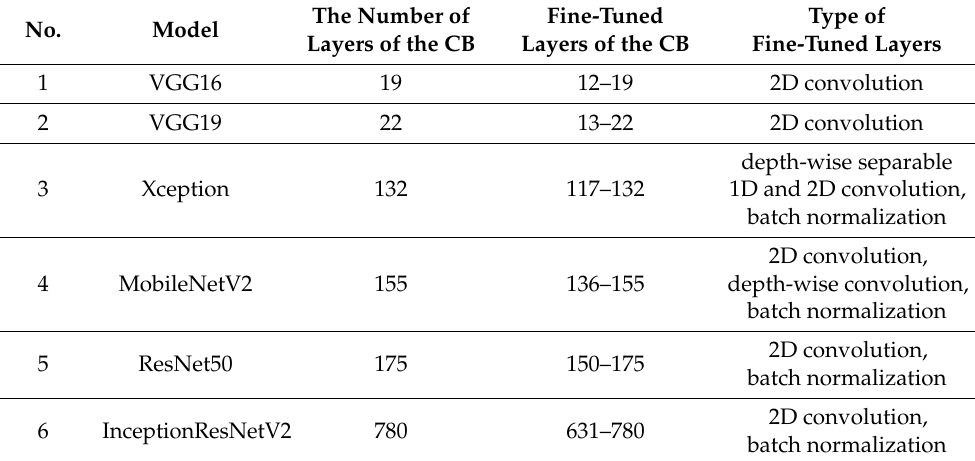
Table 1. Models for image classification with weights trained on ImageNet that have been used in the study (CB—Convolution Base).